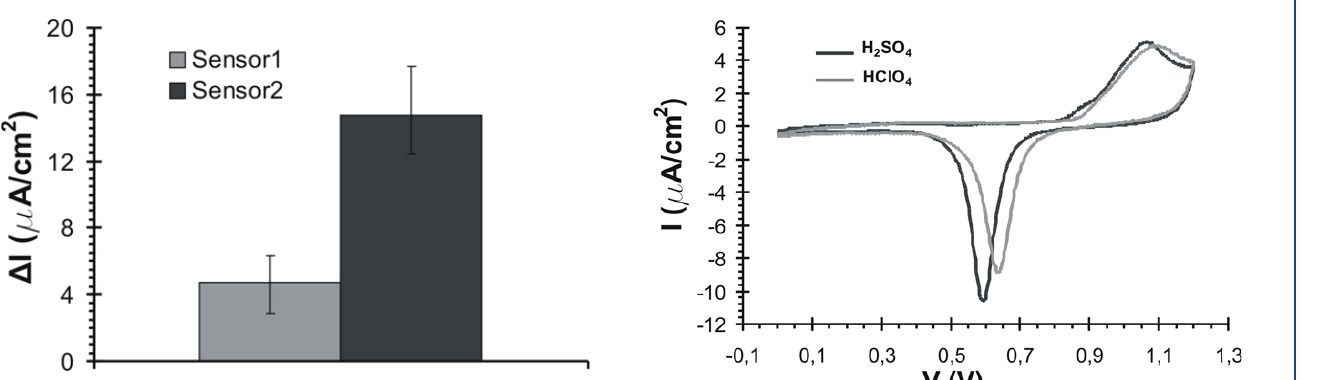
Figure 5. Cyclic voltammogram of the gold electrodes after H 2 SO 4 and HClO 4 electropolishing.